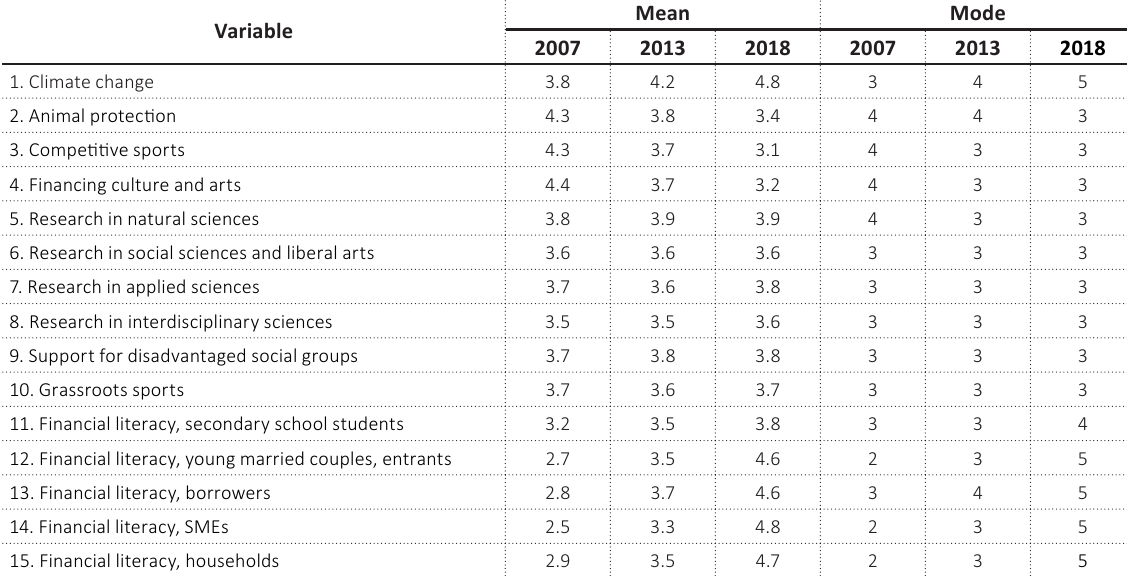
Table 3. CSR survey, 2007